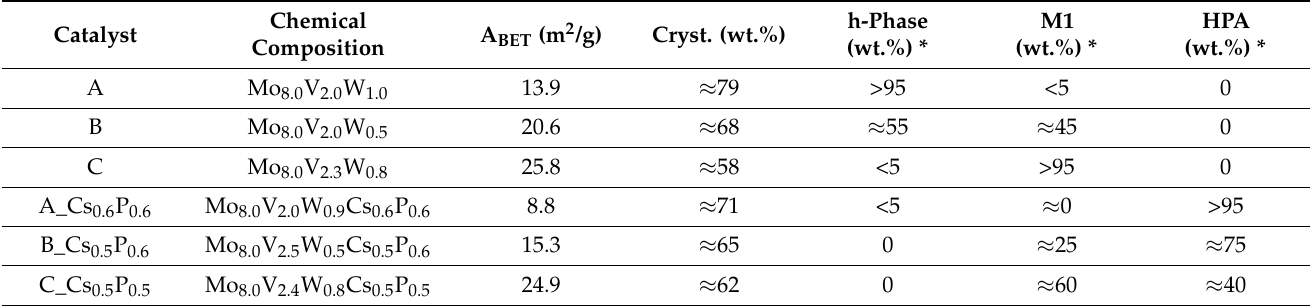
The elemental ratios are normalized to Mo 8 . * numbers refer to the crystalline portion of the